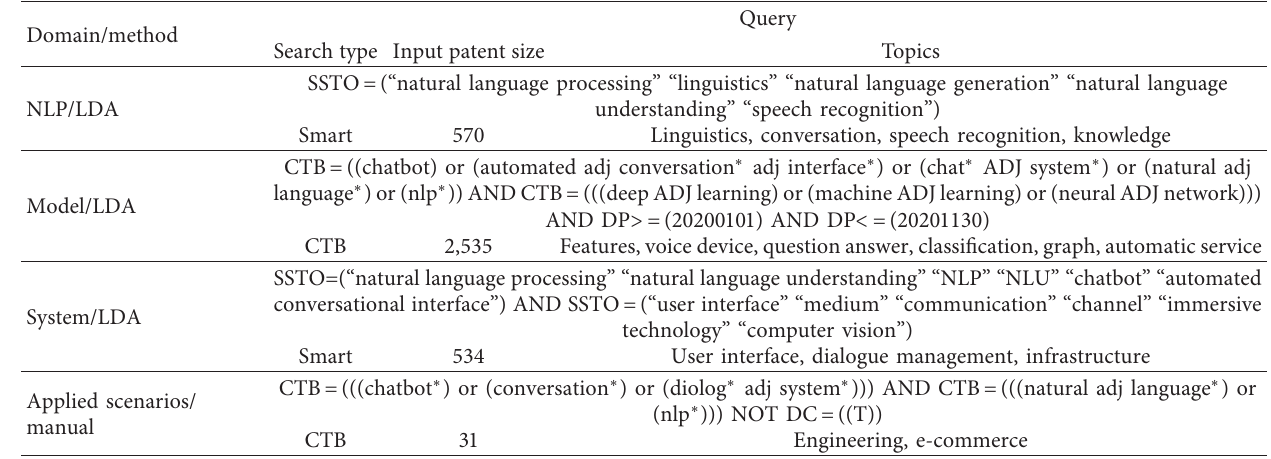
Table 5: Topics in each domain.